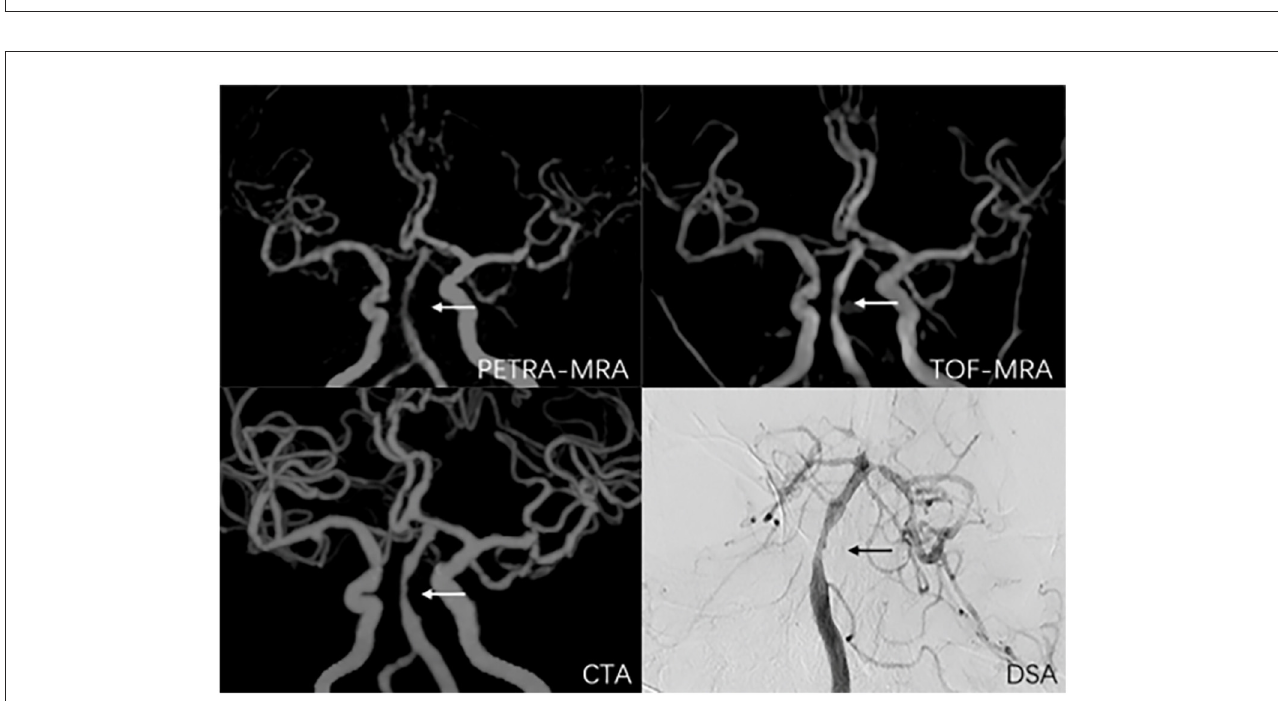
FIGURE5 A 56-year-old man with symptomatic basilar artery stenosis. The arrow marks the location of the lesion. The degree of stenosis was 59.9% on PETRA-MRA, 51.1% on TOF-MRA, 69.7% on CTA, and 50.3% on DSA. Lesion length was 5.36mm on PETRA-MRA, 5.43mm on TOF-MRA, 5.76mm on CTA, and 5.05mm on